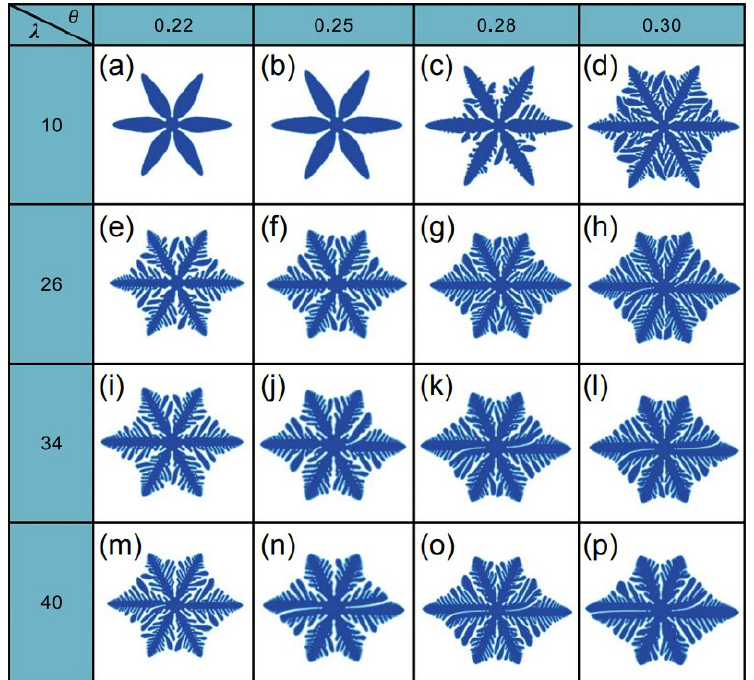
Figure 2. Effect of undercooling ( θ ) and coupling constant ( λ ) on dendrite morphology of magnesium alloy. ( a – p ): dendrite morphology under different undercooling ( θ ) and coupling constant ( λ ) combinations [74].